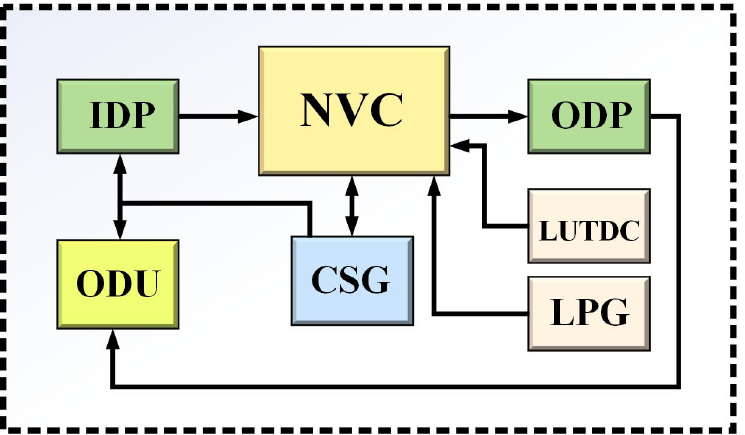
Figure 4. Overall architecture for the final digital system. Different parts of the proposed hardware have been related together.